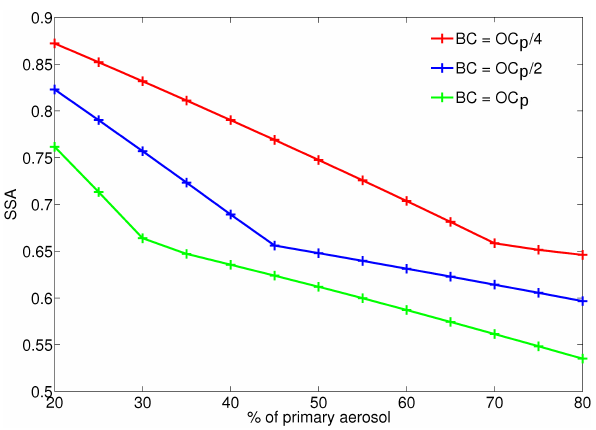
Fig. 3. Single scattering albedo at the 550nm wavelength versus percentage of primary aerosol for 3 different core compositions with a median radius of 0.15µm and a geometric standard deviation of 1.65. to the same median radius of 0.045 µm and the three geo- metric standard deviation are overlaid in red blue and